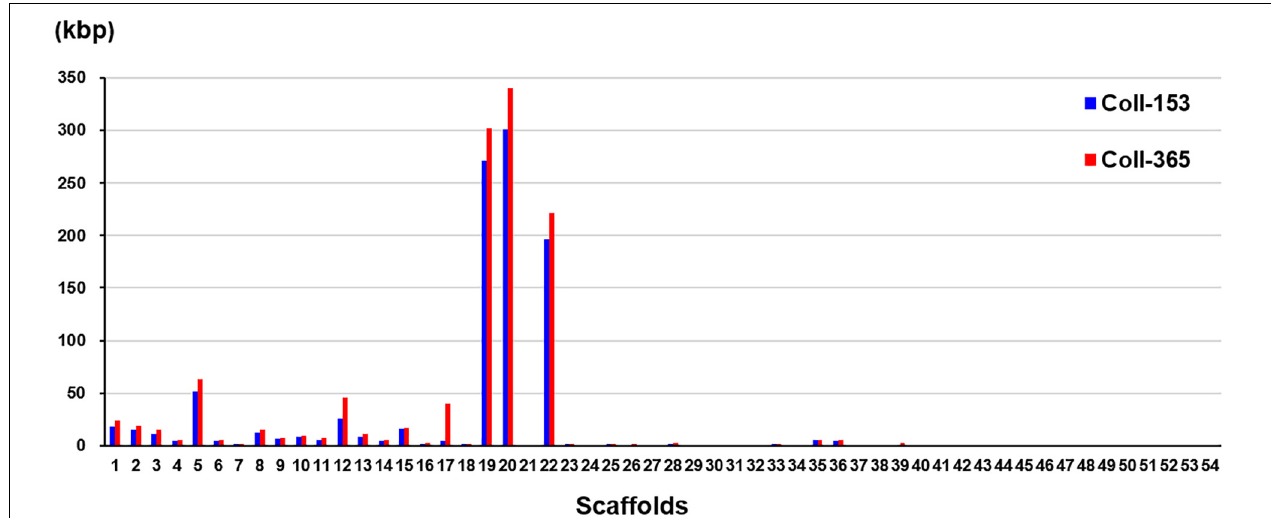
FIGURE 3 | DNA sequence removal in strains Coll-153 and Coll-365 compared to strain Coll-524. Total nucleotides removed in each scaffold were indicated as blue and red bars for Coll-153 and Coll365.